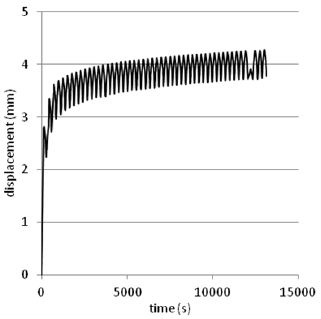
Figure 8. Plot of displacement over time from cCBR tests (soaked